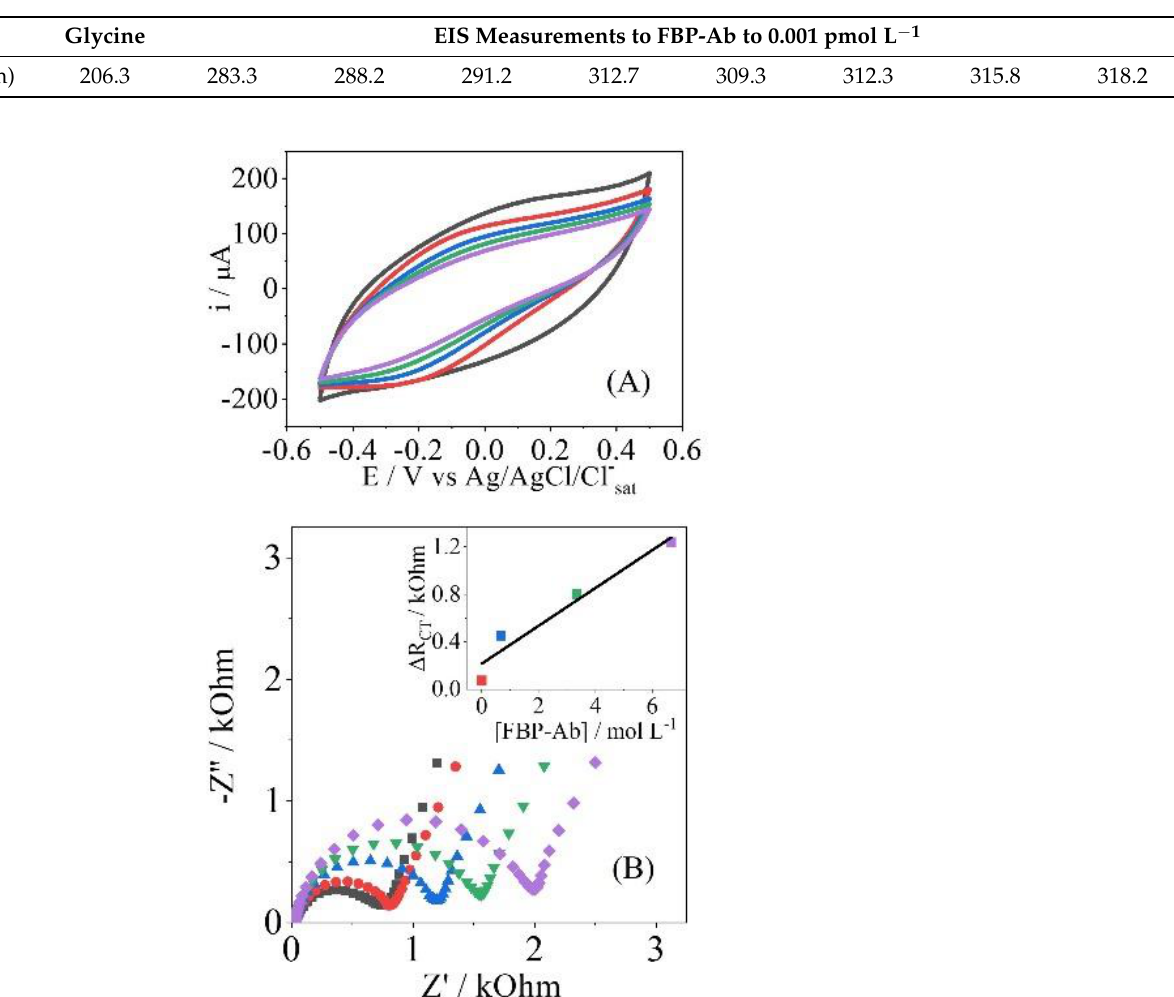
Table A2. Parameters’ values obtained by EIS to PPy e PPy/AuNPs for stabilization tests using 0.001 pmol L − 1 .